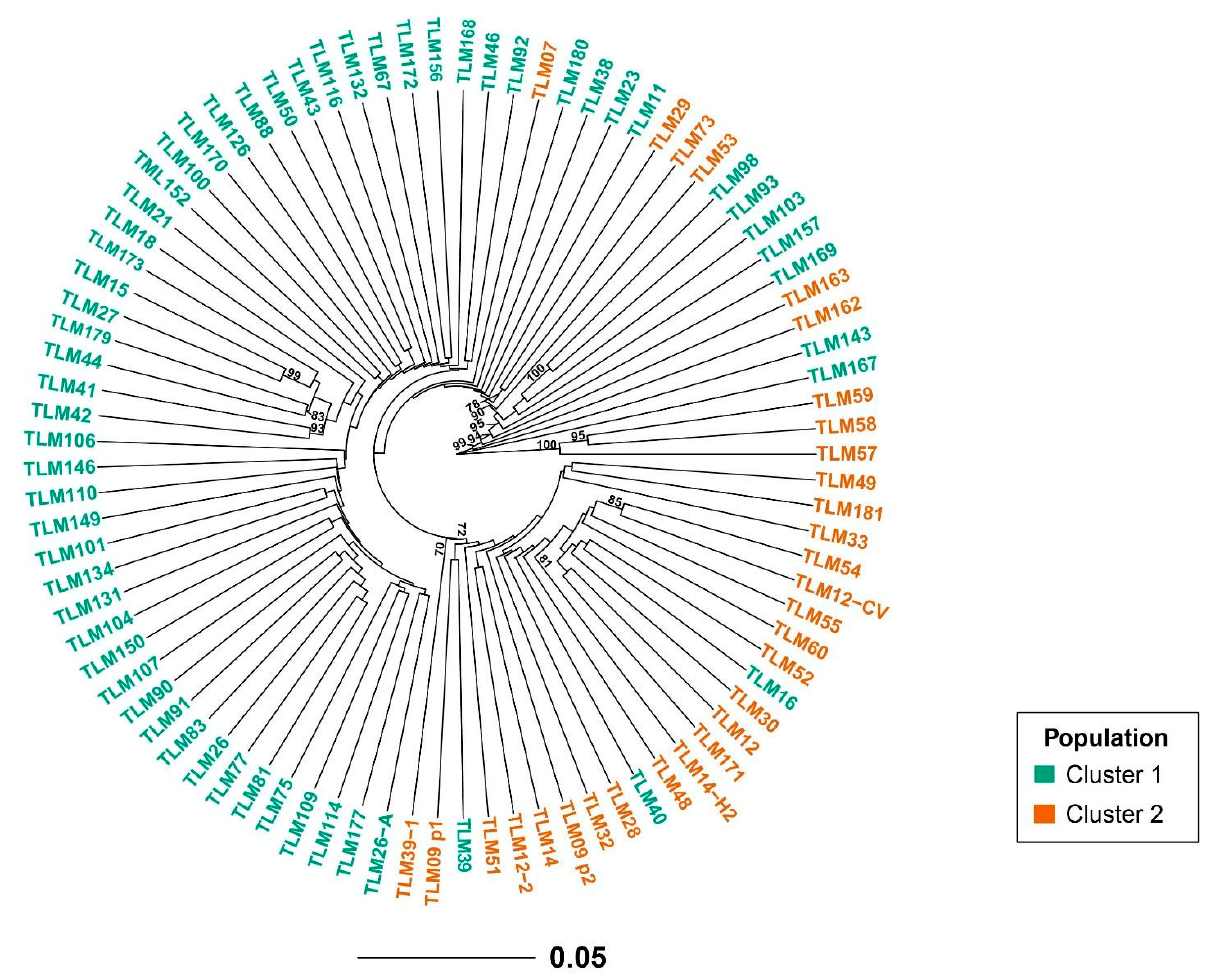
Figure 4. Dendrogram based on Provesti’s genetic distance and the UPGMA clustering method for 89 accessions of tarwi using 5922 SNP markers. Bootstrap values greater than 70% are shown.